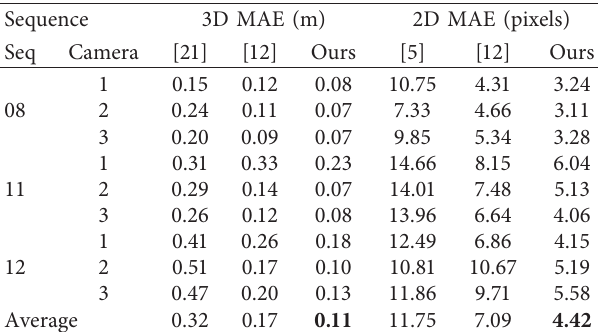
Table 1: MAE in 3D (m) and on the image plane (pixels) on seq08, seq11, and seq12 over cameras 1, 2, and 3.